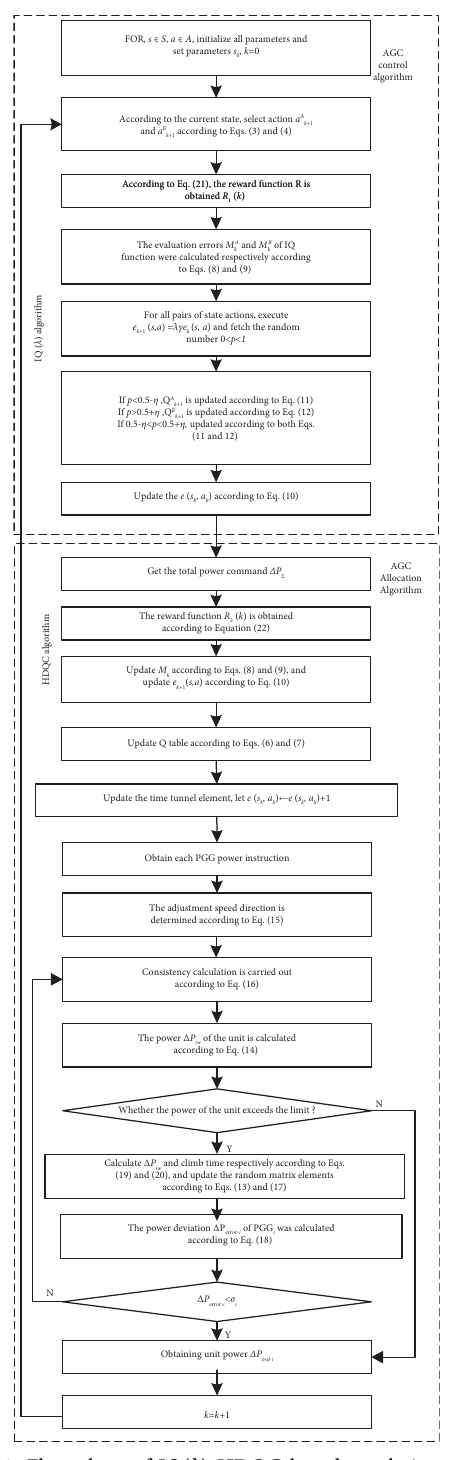
Figure 2: Flow chart of IQ( λ )-HDQC-based regulation